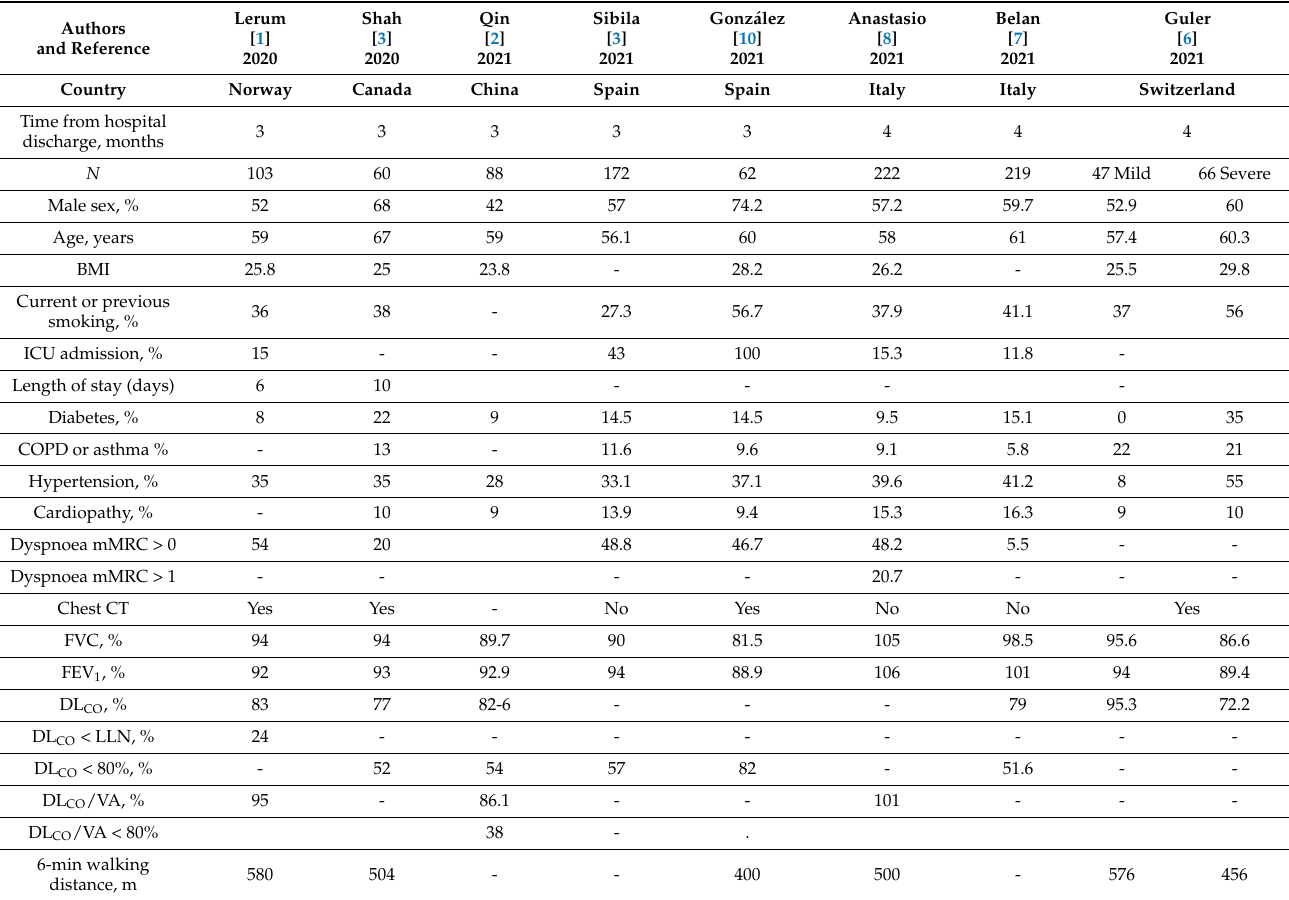
Table 7. Comparison of the principal variables of the main published series that had evaluated pulmonary function tests three-to-four months after patient hospitalisation for COVID-19